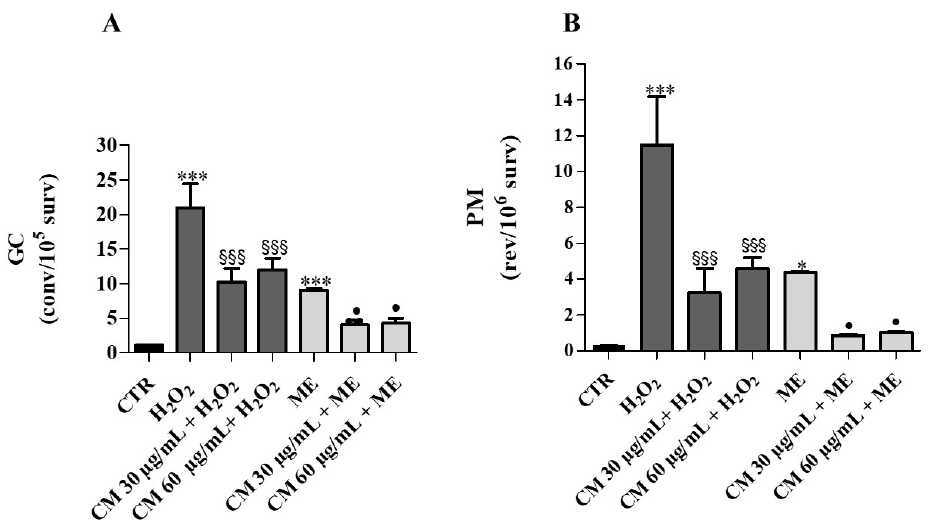
Figure 5. Incubation assay: Effects of C. maritimum L. extract (CM) (30 and 60 µg/mL) on Saccharomyces cerevisiae yeast exposed to an oxidative insult by H 2 0 2 (4 mM) and ME (0.15 mM). ( A ), GC frequency expressed as convertants/10 5 survivors; ( B ), PM frequency expressed as revertants/10 6 survivors. Values are expressed as the mean ± SD of three independent experiments and analyzed by one-way ANOVA with Tukey multiple comparison test. Significant difference from CTR: * p ≤ 0.05; *** p ≤ 0.001. Significant difference from H 2 O 2 : §§§ p ≤ 0.001. Significant difference from ME: • p ≤ 0.05.